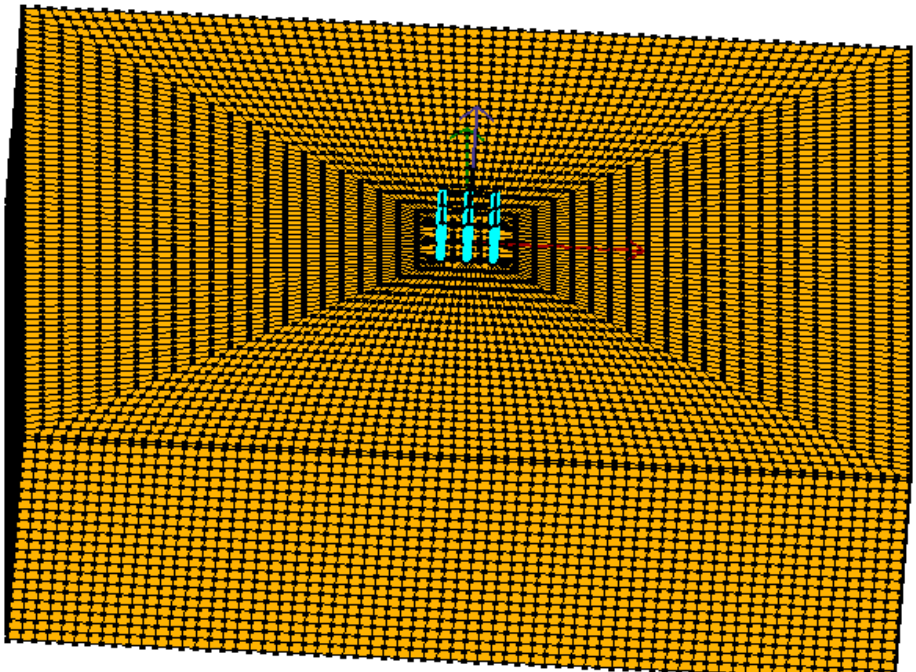
Figure 3. Three-dimensional (3D) mesh (Model 2).